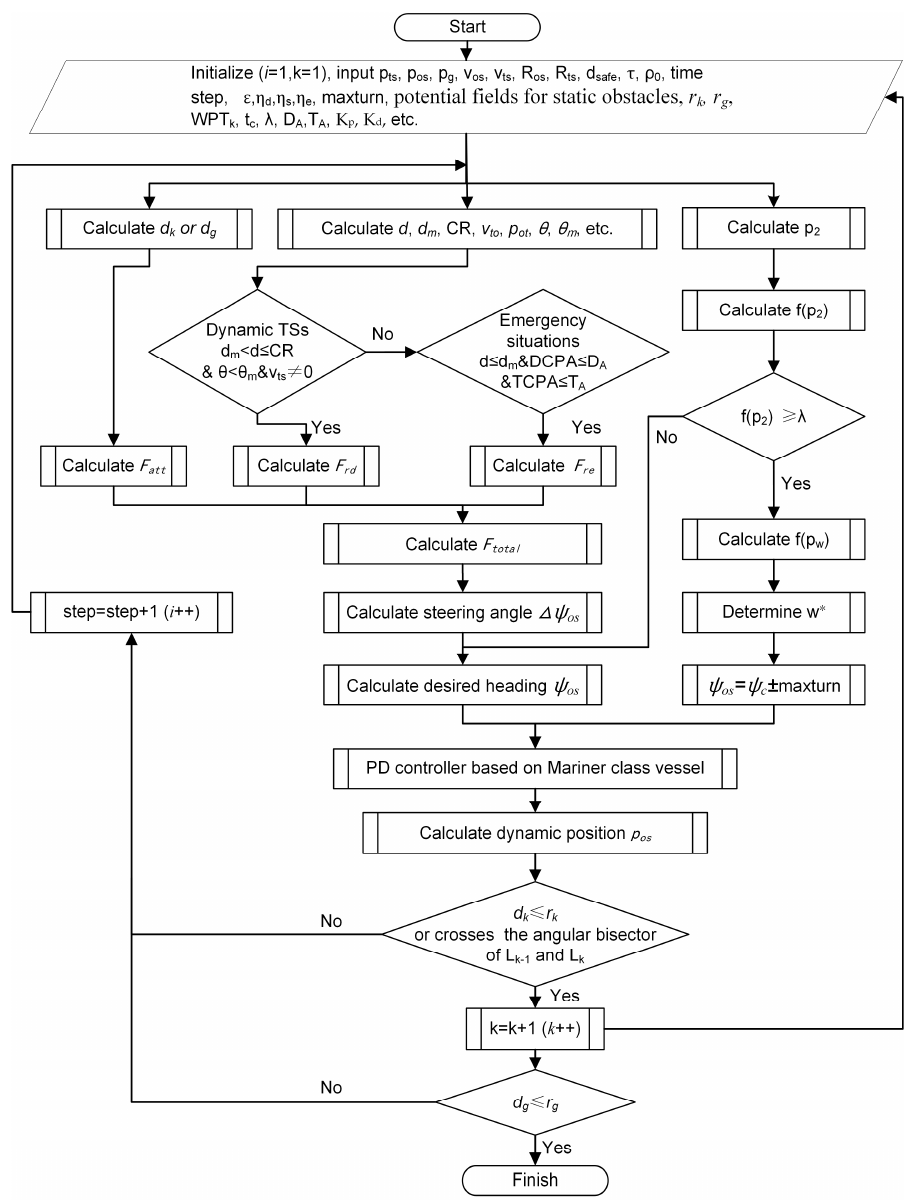
Figure 10. Flowchart of the PGHAPF method; WPT; checking range (CR); target ships (TSs); DCPA; time to the closest point of approach (TCPA); proportional derivative (PD).